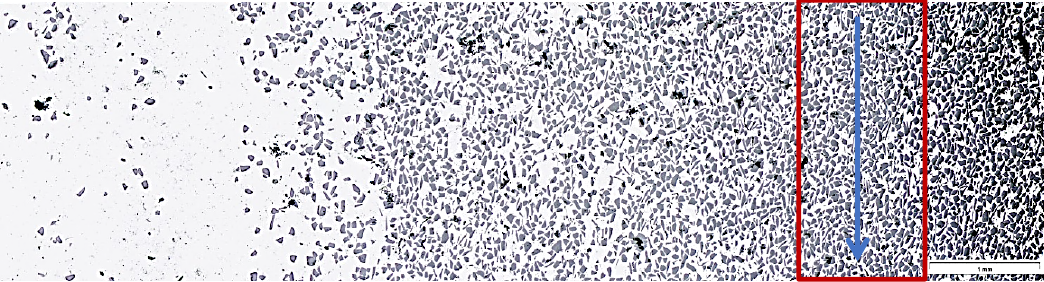
Figure 5. LM microstructure of reinforcing particles distribution on a cross-section of the tested AlSi12 / SiC p composite layer; unetched section. The blue arrow indicates the area and direction of the scratch test.